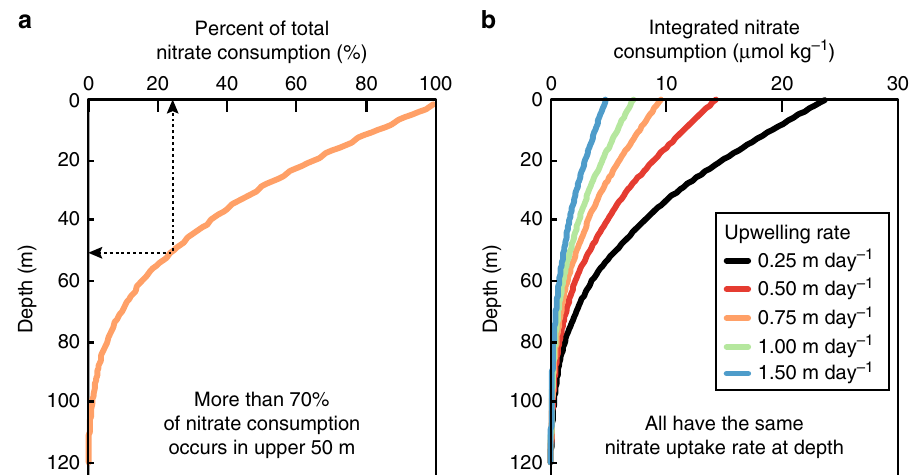
Fig. 6 Simple models of nitrate consumption at the equator. Nitrate consumption increases as equatorial waters upwell towards the surface, and the degree of consumption is related to upwelling stength. Here we plot the nitrate consumption a as a percentage of the initial nitrate concentration and b in terms of nitrate concentration with varying upwelling rates. The integrated percentage of nitrate consumption in a is based on observed nitrate uptake rate with depth 21 and total nitrate consumption (Table 1) at 0° N, 110° W from December 2004. Note that most nitrate consumption occurs in the upper 50 m, suggesting that light limitation can only play a minor role in modifying elemental requirements (e.g., lower C:N at lower light levels 71 ). The same nitrate uptake rates were used to calculate the integrated nitrate consumption in b for a variety of upwelling rates, and we found that increasing upwelling rate decreases the integrated nitrate consumption in the water upwelling at the equator (see "Methods"). The same source water depth and iron recycling rate are assumed in all